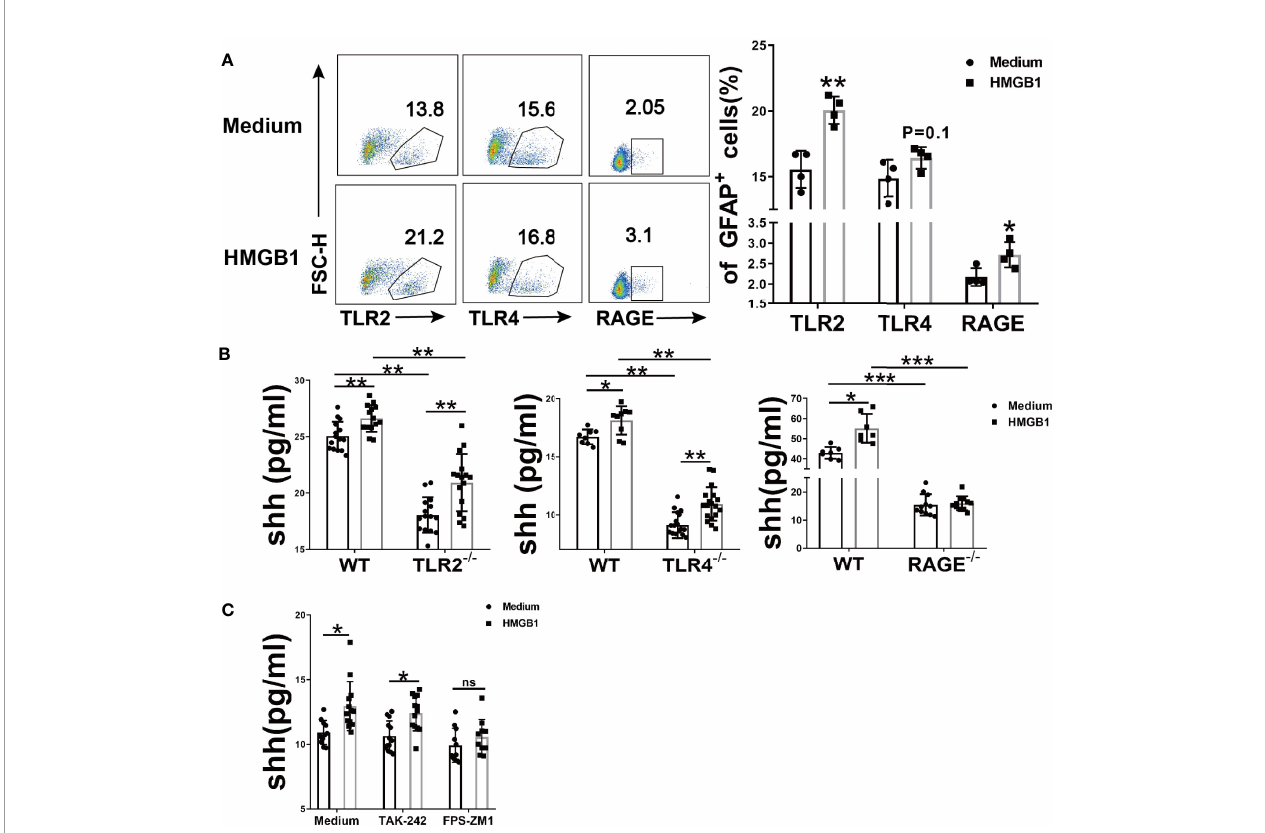
FIGURE 2 | The effect of HMGB1 receptors on the release of shh in astrocytes. (A) Three surface receptors for HMGB1 were analyzed by fl ow cytometry after HMGB1 stimulation (2 m g/ml) in astrocytes. (B) The release of shh from astrocytes was detected after TLR2, TLR4 and RAGE were knocked out (2 m g/ml and 1 m g/ml recombinant HMGB1 was used in TLR2, TLR4 and RAGE knockout astrocytes respectively). (C) The effect of TLR4 blocker (TAK-242: 100nM) and RAGE blocker (FPS-ZM1: 148nM) on the release of shh in astrocytes (1 m g/ml recombinant HMGB1 was used). Data are shown as mean ± SD (* P < 0.05, ** P < 0.01, *** P < 0.001). ns, no signi fi